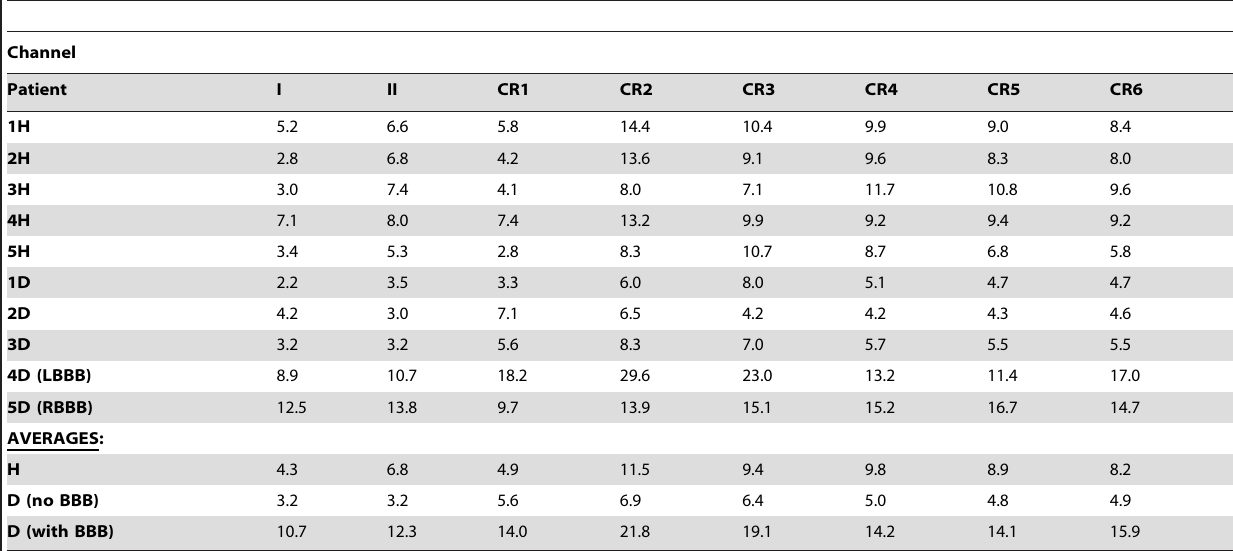
Table 1. RMS difference values for all 10 patients’ original versus re-digitized files when both the original and re-digitized files were collected on the same model of Cardiax ADC.